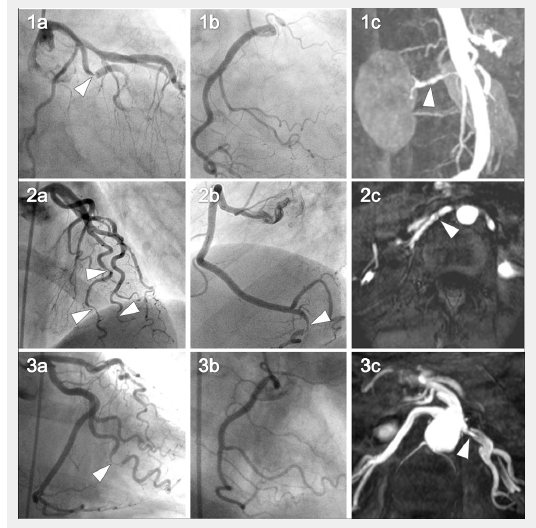
Figure 3 Coronary angiography and renal MR angiography of the 3 women with renal artery abnormalities. The left (images 1a, 1b, 1c) and right coronary (images 2a, 2b, 2c) angiography is shown for all three patients with the corresponding renal artery abnormalities (images 3a, 3b, 3c). Arrows in images 1a–c and 2a–c point at spontaneous coronary artery dissections. Arrows in images 3a–c point at renal artery fibromuscular dysplasia (3a, 3b) and renal artery dissection